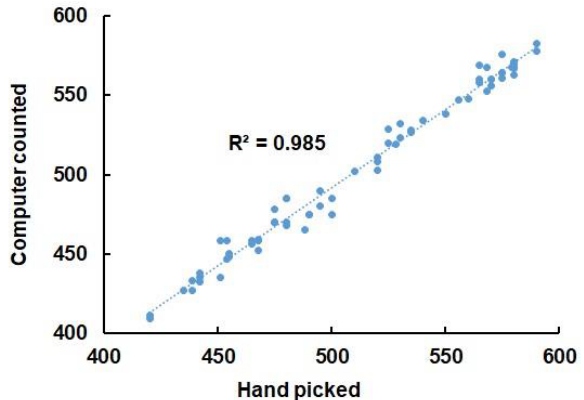
Figure 14. Correlation between mangos counted by the computer and those picked-up by the workers.